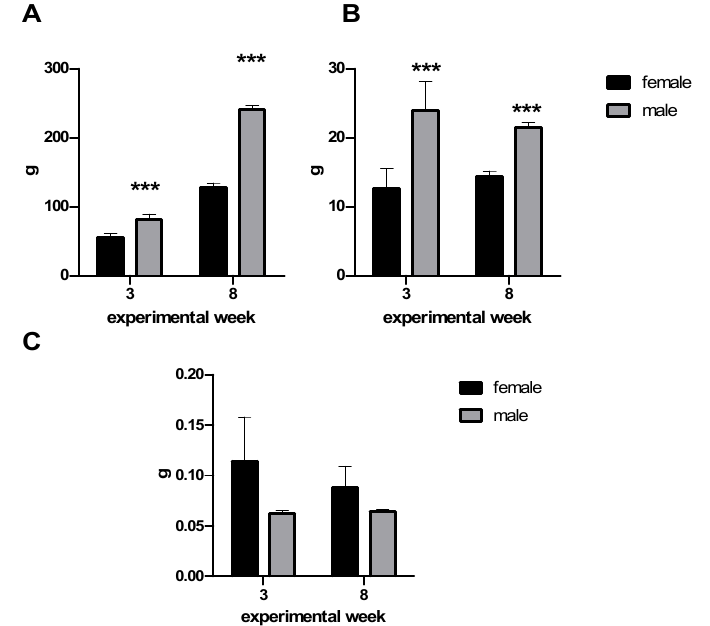
Figure 1. ( A ) Body mass gain, ( B ) food intake, and ( C ) food intake per gram of body weight during the third and eighth experimental weeks. Data are expressed as mean ± SD. Significance is given by *** p < 0.001.